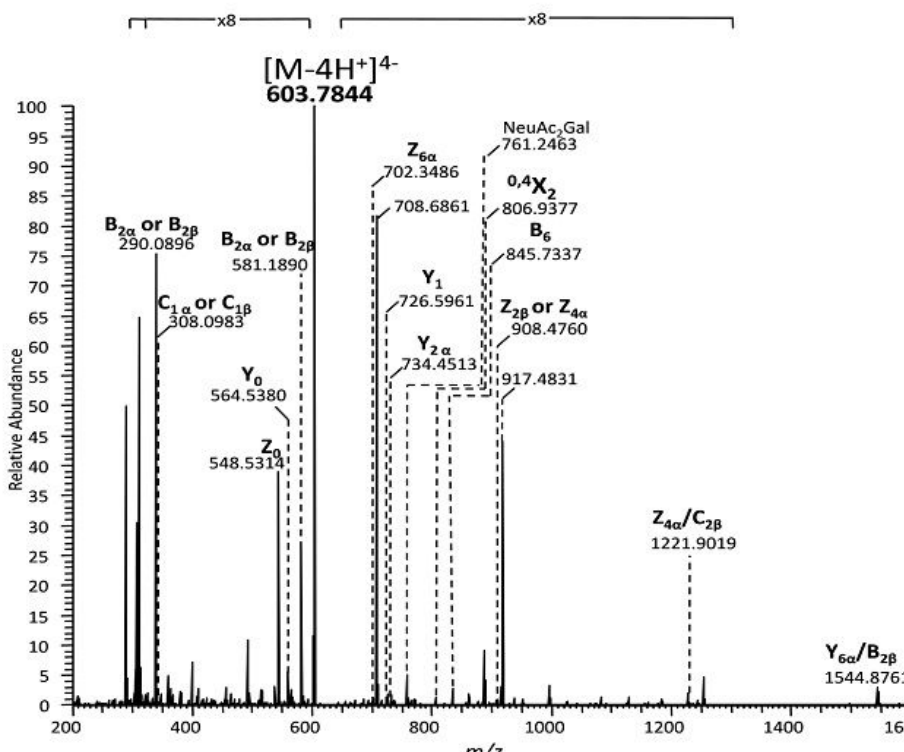
Figure 5. ( − ) NanoESI HR HCD MS/MS of the [M − 4H + ] 4 − detected at m/z 603.7844 assigned according to mass calculation to the tetrasialotetraose GQ1(d18:1/18:0). The mass spectrum is a sum of the scans acquired over the entire E lab collision energy range of (35–80) eV, using stepped HCD method; acquisition time: 2 min; other conditions as in Figure 2.